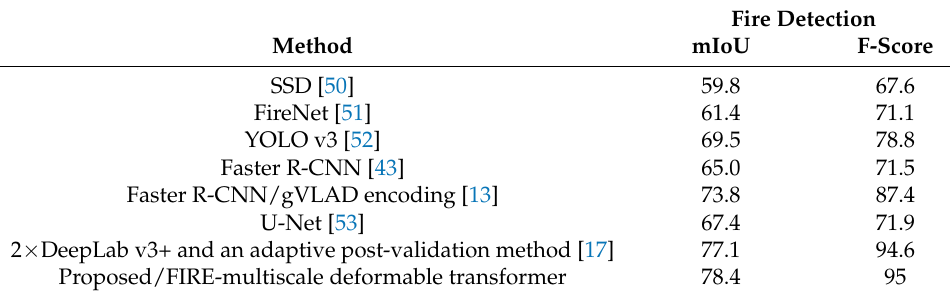
Table 2. Comparison